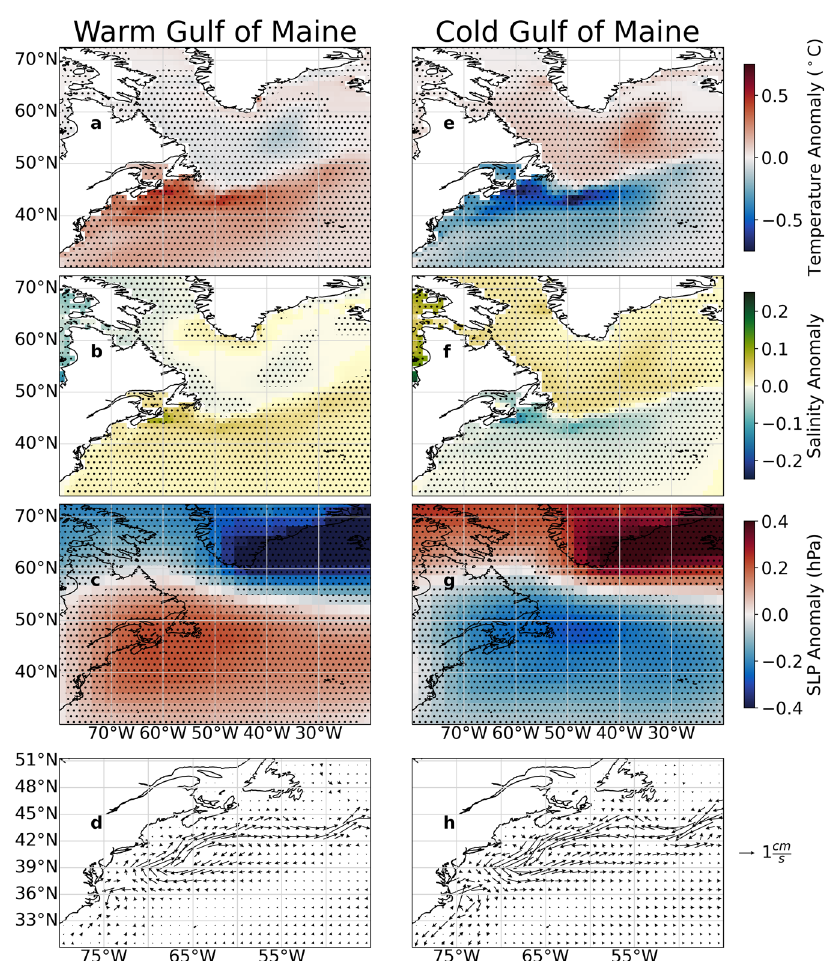
Fig. 7 North Atlantic conditions during extreme temperature years in the Gulf of Maine. Simulated anomalous conditions in the North Atlantic during periods with extremely warm ( a – d ) and cold ( e – h ) temperature in the Gulf of Maine in the individual ensemble members of the climate model (averaged together for this fi gure) over the period of overlap with the geochemical records in this study (1685 – 2005): a , e : Temperature (upper 200 m average), b , f : Salinity (upper 200 m average), c , g : Sea level pressure (SLP), d , h : ocean current velocity (upper 200 m average). Stippling in a – c and e – g identify anomalies signi fi cant at the 95% signi fi cance level. Only vector anomalies signi fi cant at the 95% signi fi cance level were plotted in d and h